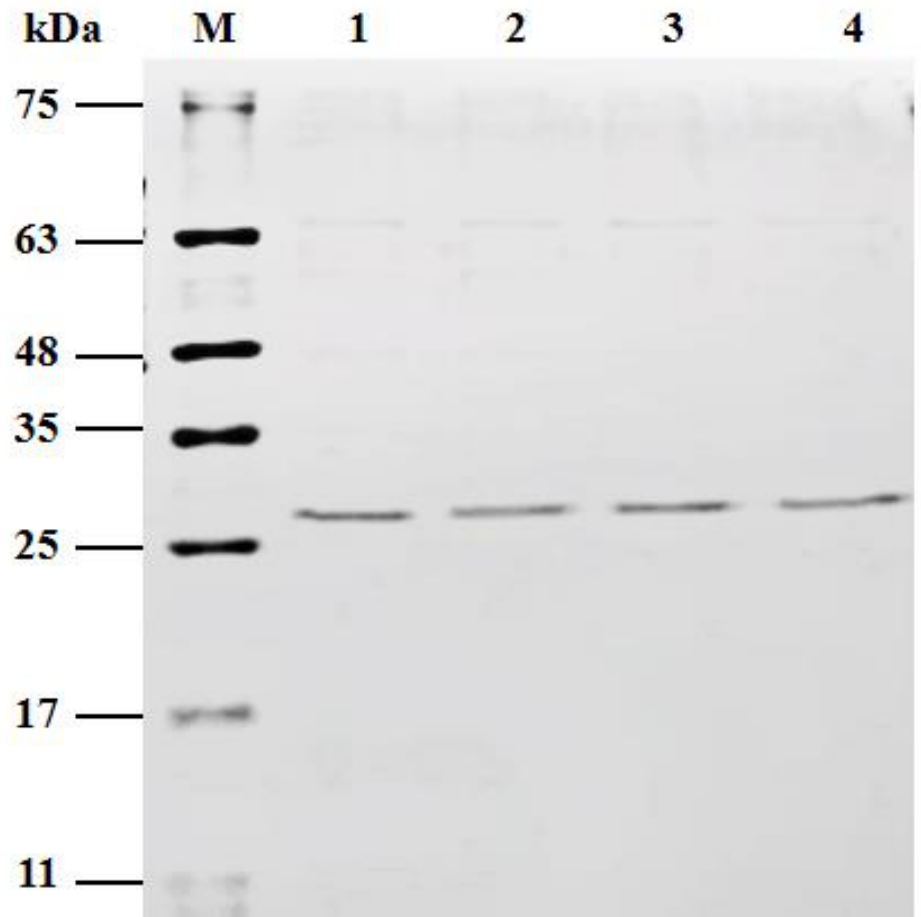
Figure 2. SDS-PAGE analysis of the wild-type XynASP and single mutants. M: Protein Marker; 1: the purified wild-type XynASP; 2: the purified mutant T41V; 3: the purified mutant A79Y; 4: the purified mutant T81Q.